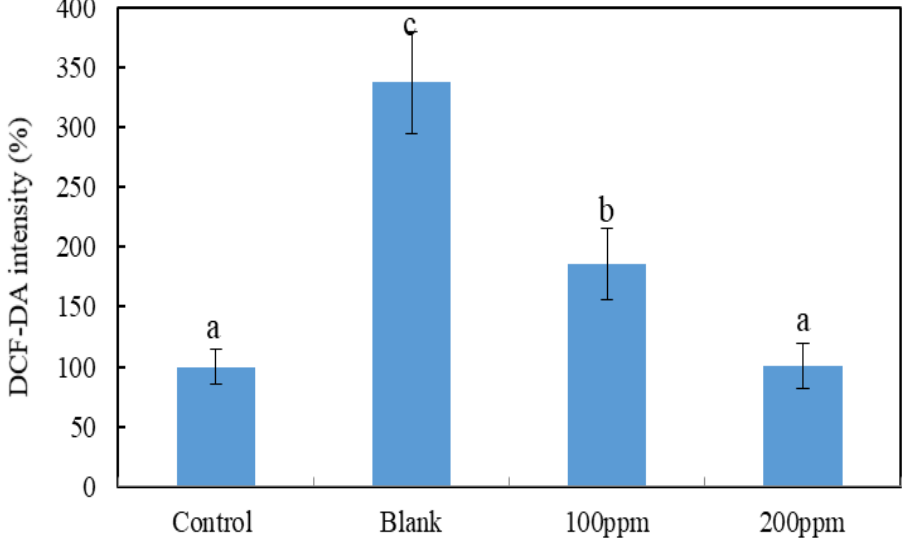
Figure 3. The protective effect of white truffle mycelial products on hydrogen peroxide-induced oxidative stress in zebrafish embryos. Data are expressed as mean ± S.D. ( n = 20). a, b, c Means with different letters are significantly different ( p < 0.05). Soaking solution contained 100 and 200 ppm hot water extracts of white truffle solid-state fermented mycelial product.